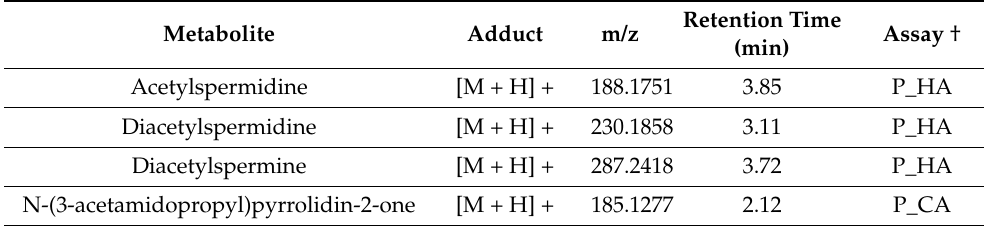
Table A3. Coefficient of variation (CV) values for measured polyamines in pooled quality control samples.